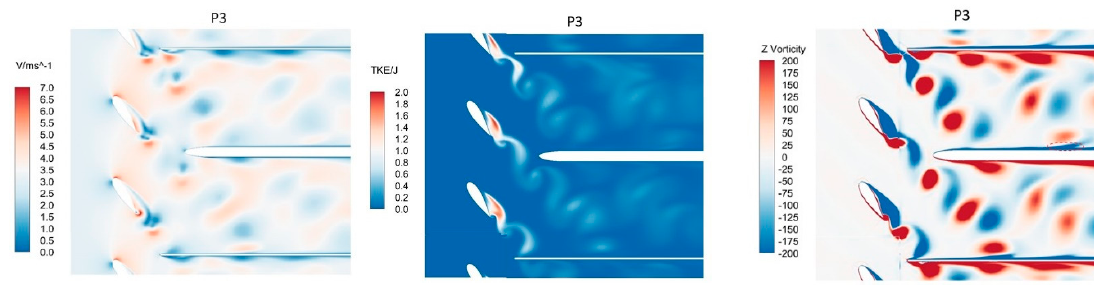
( c ) Contours at phase 3, left: velocity, middle: turbulence kinetic energy, right: z vorticity. Figure 13. Distributions of phase-averaged results at three selected phases at f = 30 Hz .